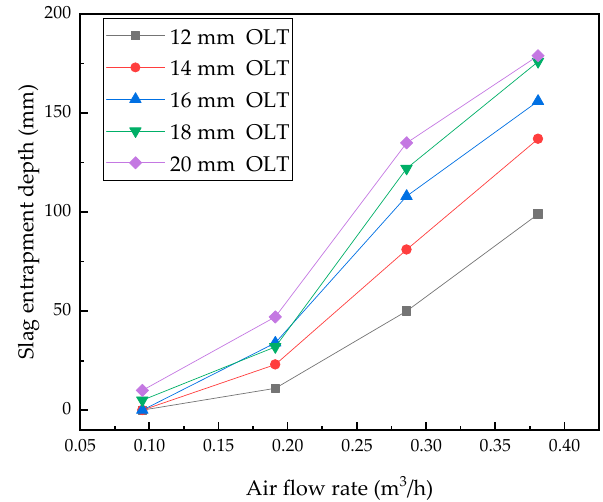
Figure 9. The influence of a double porous plug bottom flow rate to entrapping depth in the water model.